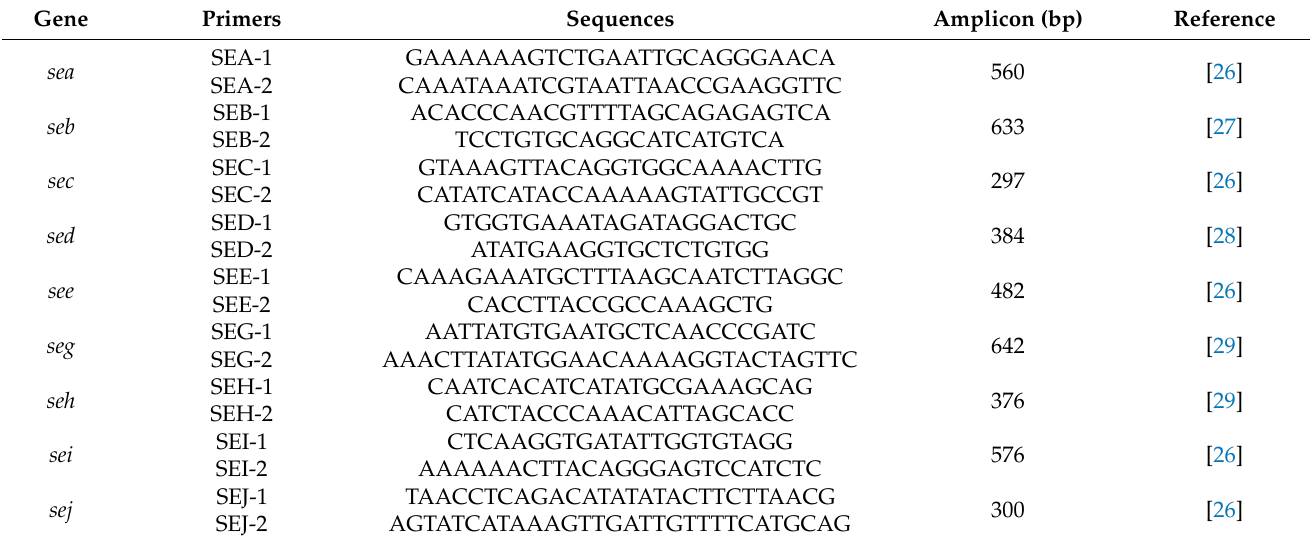
Table 2. Primers used in the investigation of staphylococcal enterotoxin